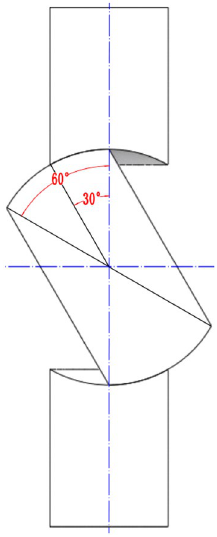
Figure 3. Diagram of valve